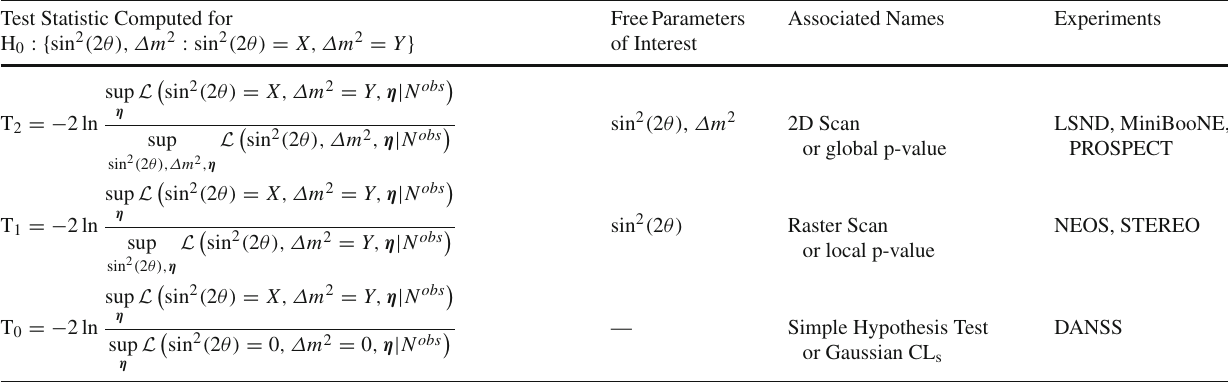
Table 2 Definition of the test statistics used for sterile-neutrino searchesinthepresenceofnuisanceparameters( η ).Thenullhypothesis is H 0 : { sin 2 ( 2 θ),Δ m 2 : sin 2 ( 2 θ) = X ,Δ m 2 = Y } for all tests while the alternative hypothesis H 1 changes. The free parameters of interest